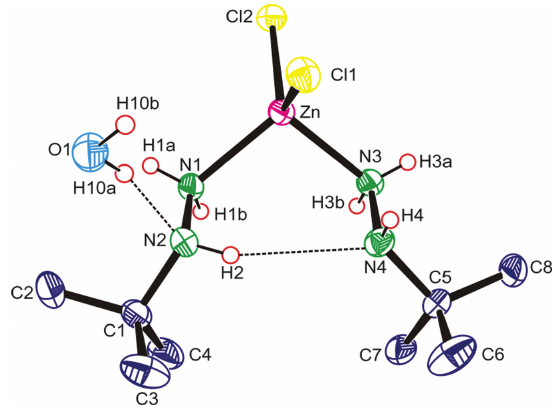
Figure 1: The asymmetric unit of 1 , showing the labelling scheme used in the text. Ellipsoids are given at the 40% level. Hydrogen atoms which form part of the t-Bu group have been omitted for